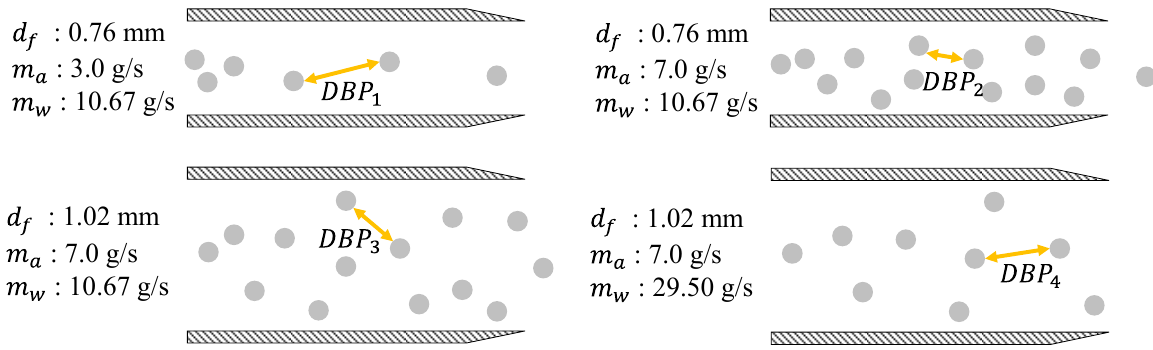
Figure 2. DBP according to AFR, WFR, and focus diameter.